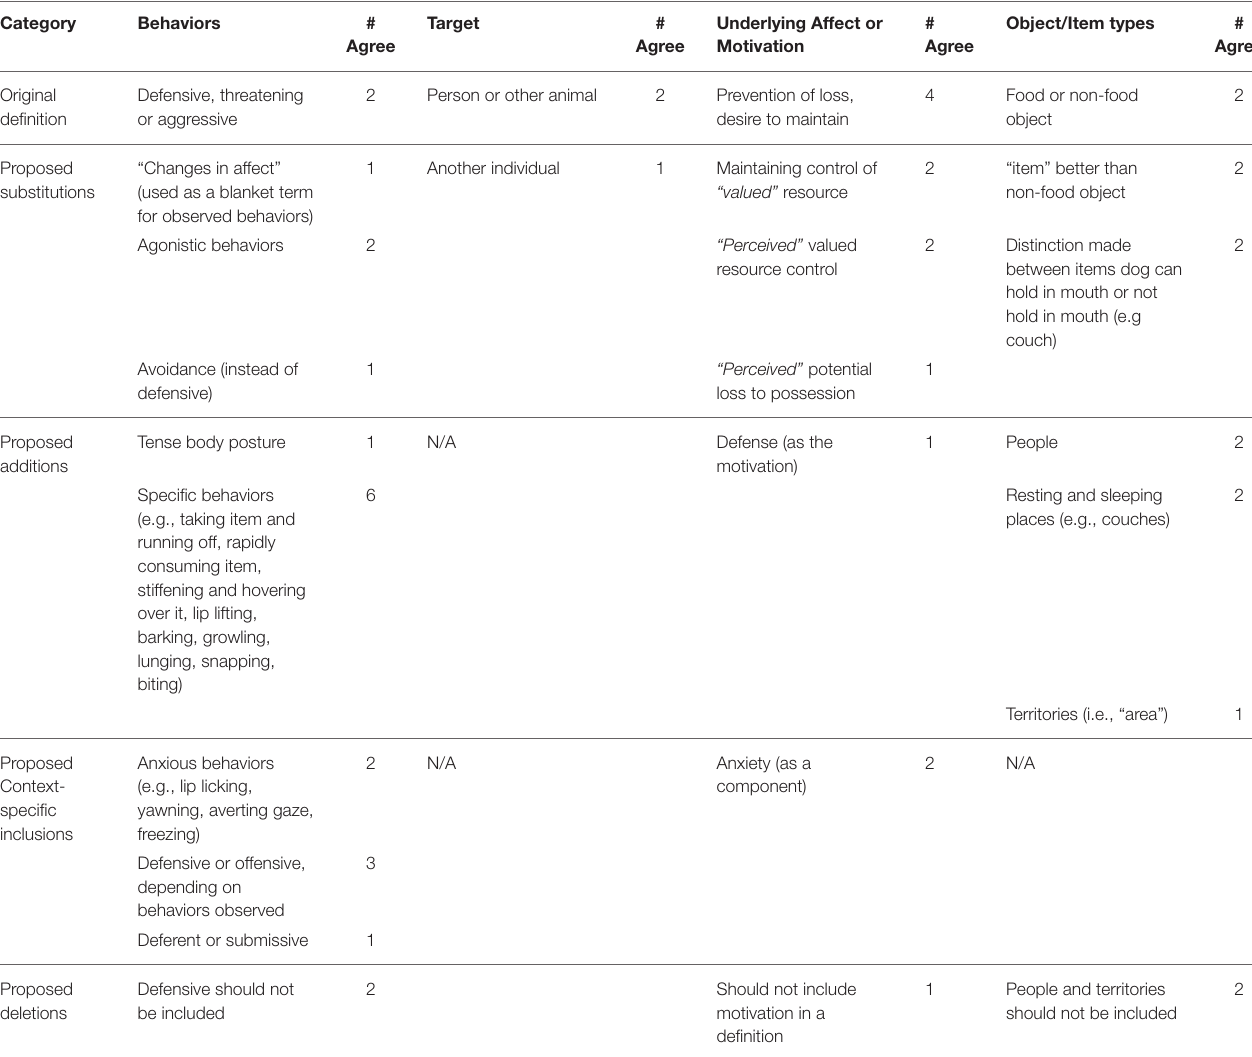
TABLE 4 | Content analysis of agreement and disagreement to the proposed definition by